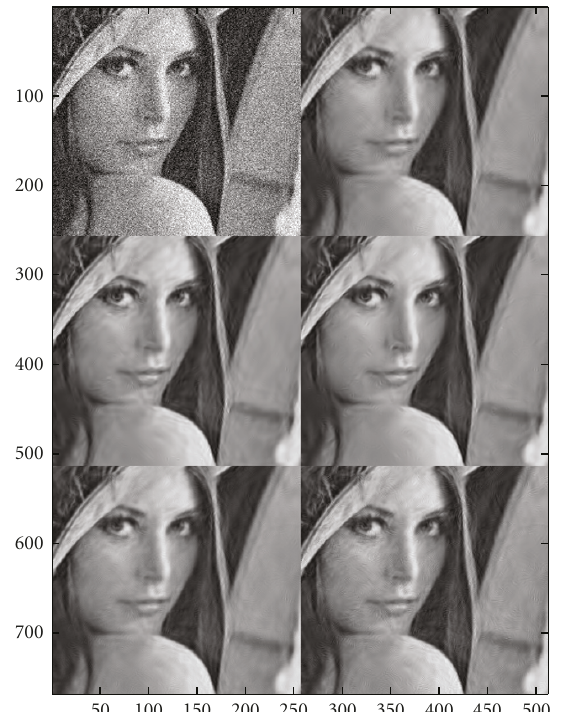
Figure 1: Image denoising results using the Lena image added with random noise ( σ e = 25). Images shown from top to bottom, left to right are the noisy results of algorithms in [16, 39, 40], the proposed IGWE-T and GWE2 algorithms. Typical PSNR values for these images are listed in Table 4.